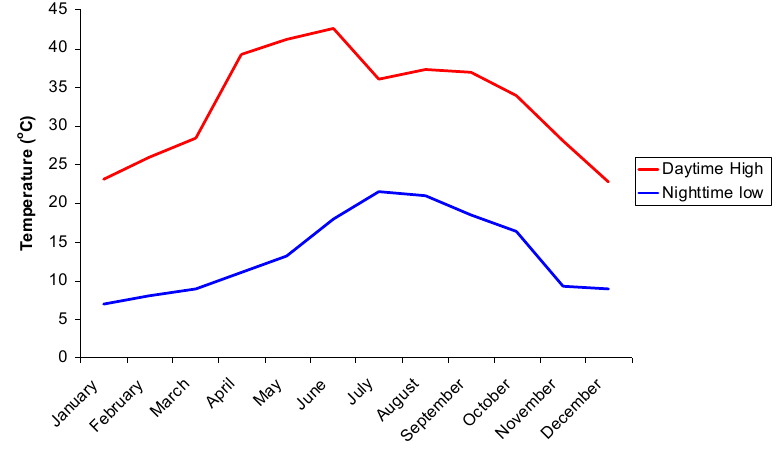
Figure 6. High and low temperature profiles for Cairo for one year.